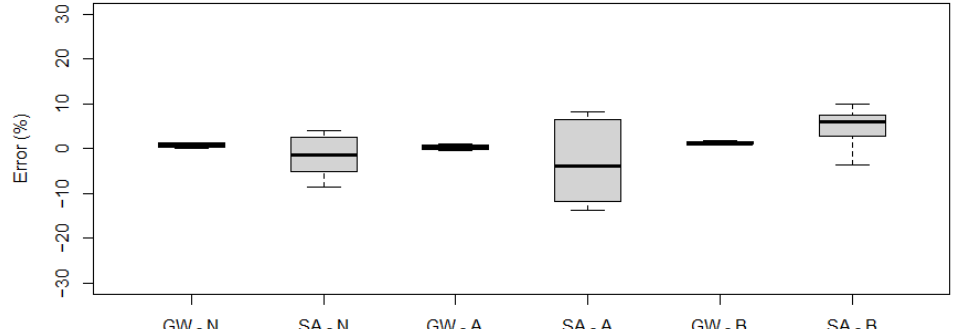
Figure 18. Measurement errors obtained for gross weight (GW), single axle (SA) for a five-axle vehicle: N—runs at constant speed, A—accelerating, and B—braking (the top and bottom of each box represent the 75th and 25th percentile values, whiskers show the minimum and maximum, the horizontal line represents the median).